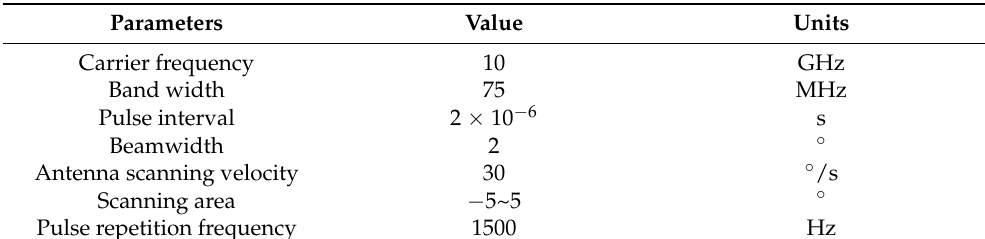
Figure 4. 1-D experiment scene of point target. ( a ) Simulated echo. ( b ) SNR = 5 dB. ( c ) SNR = 13 dB. ( d ) SNR = 21 dB. Table 1. System parameters of point target simulation.